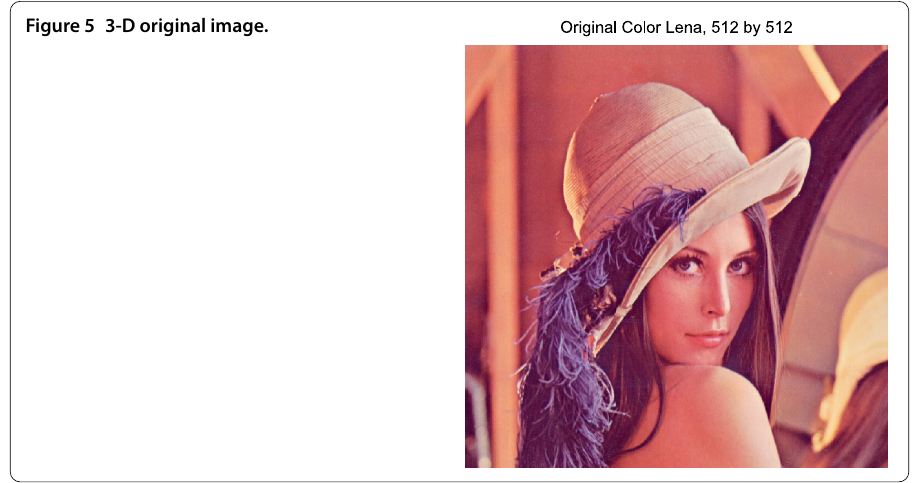
Figure 5 3-D original